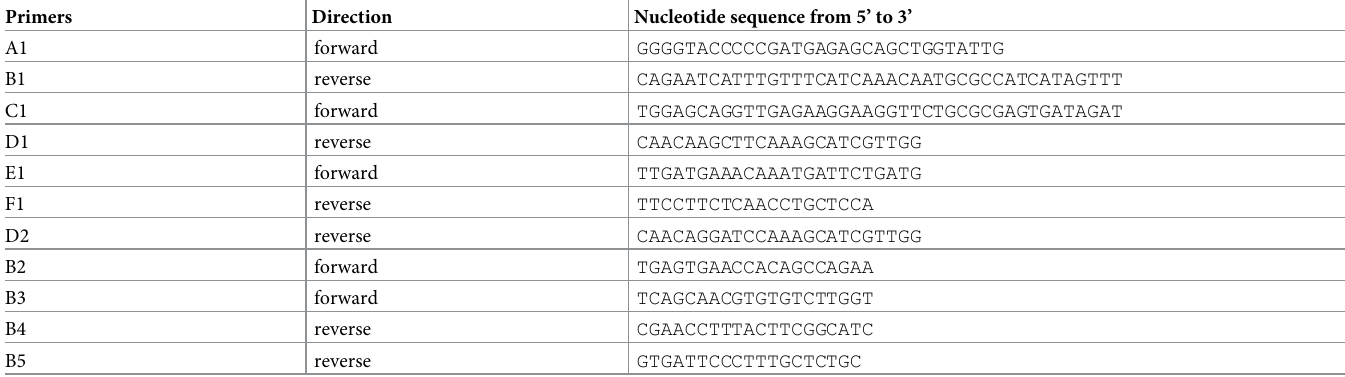
Table 1. Oligonucleotide